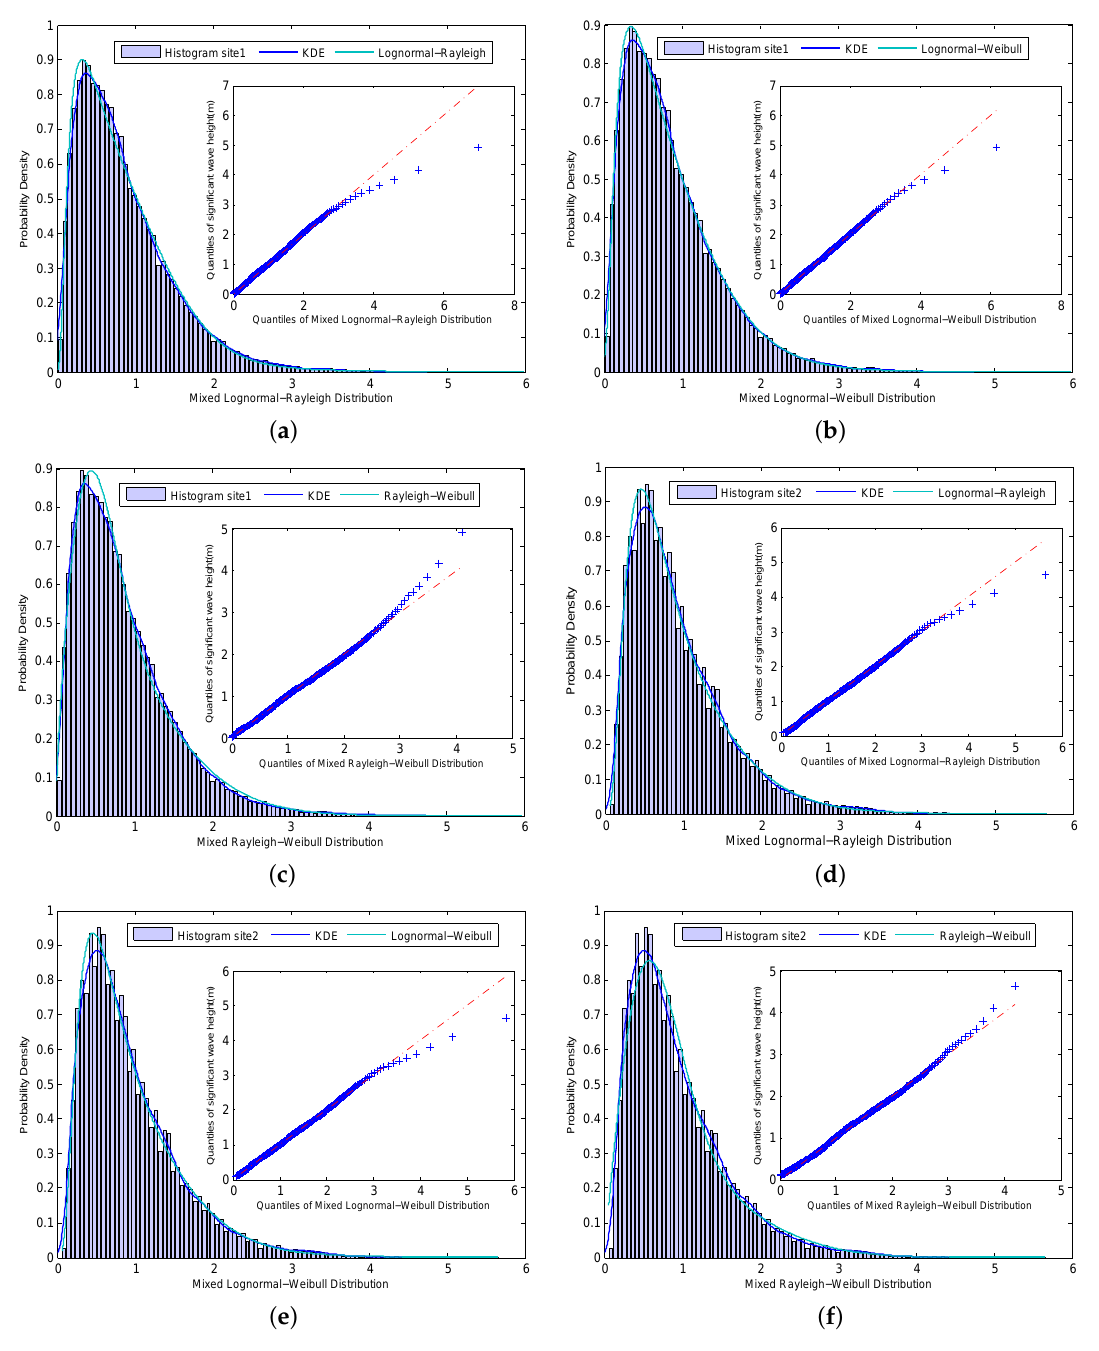
Figure 13. ( a – f ) Estimated kernel density of the significant wave heights and the mixed-distributions from Lognormal- Rayleigh, Lognormal-Weibull, and Rayleigh-Weibull distributions of the significant wave heights with the corresponding Q-Q plots of the mixed distributions of the significant wave heights for Sites 1 and